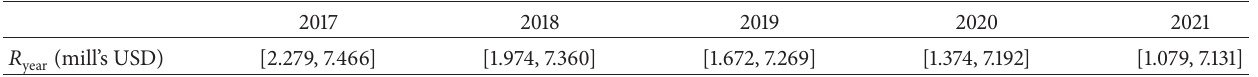
Table 4: Mine revenues over production period 2017–2021.